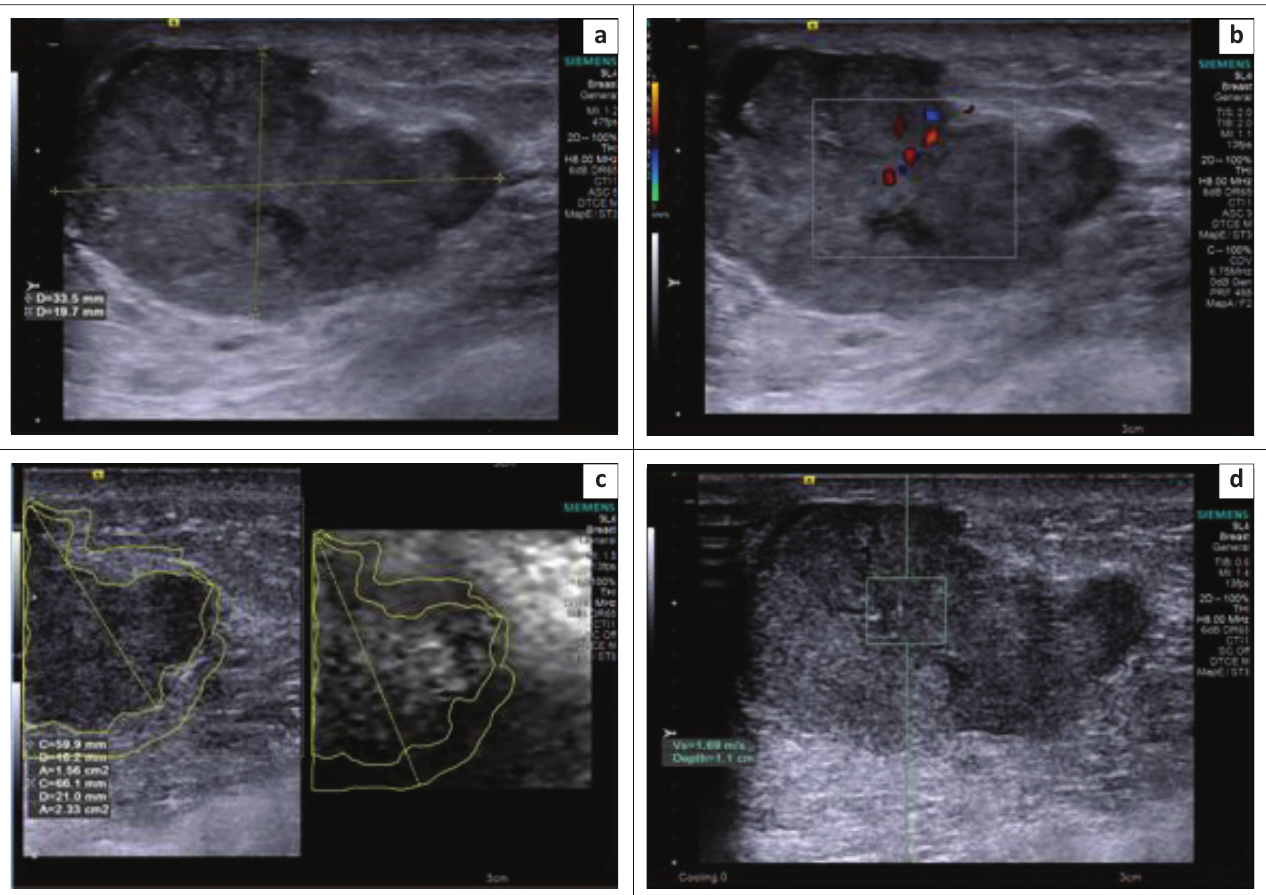
FIGURE 7: (a, b) B-mode ultrasonography image of an irregular, hypo- to isoechoic and predominantly solid lesion with few anechoic areas and internal vascularity on colour Doppler, suggesting a Breast Imaging Reporting and Data System 4 lesion; (c) elastogram showing softer areas in the centre of the lesion with a relatively firm periphery; (d) shear wave velocity in the lesion – 1.69 m/s. The final histopathological diagnosis was papillary